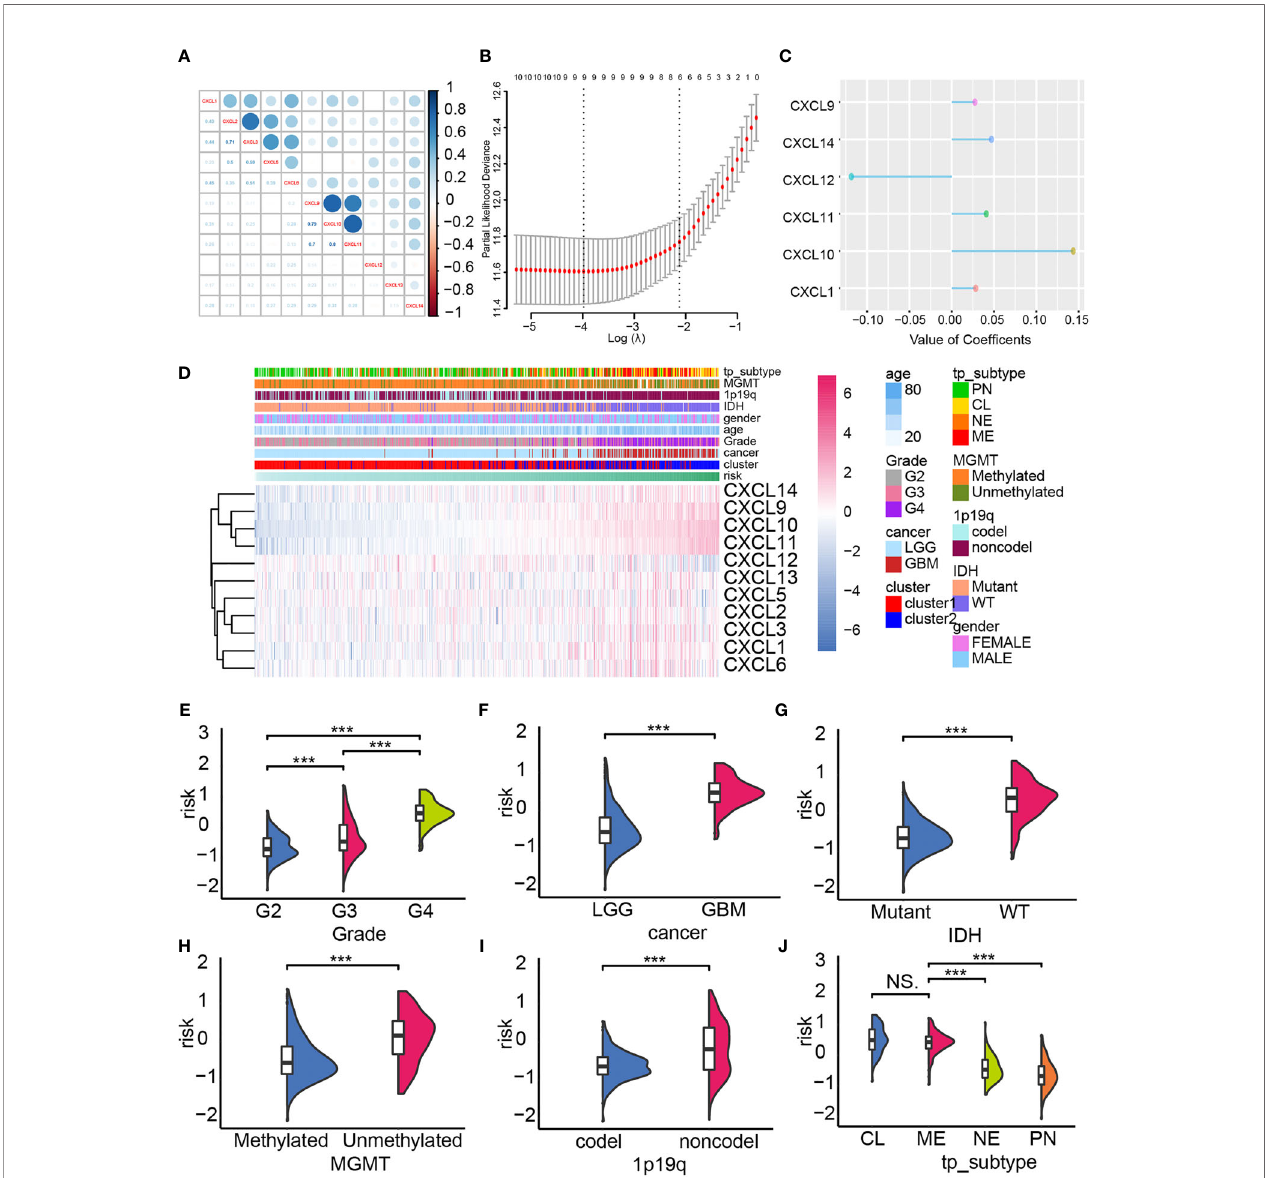
FIGURE 3 | Constructing the risk model. (A) The co-expression network of the CXCL family. (B, C) The construction of the risk model based on the expression pro fi le of the CXCL family by performing elastic net regression algorithm. (D) Heatmap displayed the alternation of the CXCL family members ’ expression according to the risk model, and corresponding clinical features were also mapped. The distribution of the risk in gliomas ’ pathological grade (E) , IDH status (F) , cancer type (G) , MGMG status (H) , 1p19q status (I) , and subtype (J) . NS, not signi fi cant, ***p <